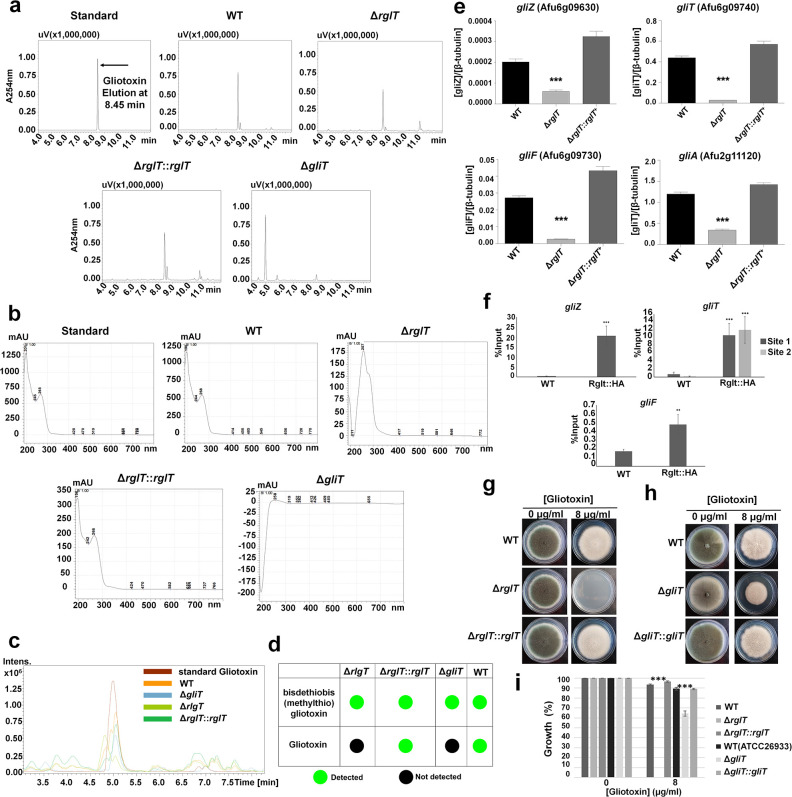
RglT is crucial for gliotoxin (GT) biosynthesis.a, HPLC (high performance liquid chromatography) analysis for GT of supernatants of different strains, that were grown for 72 h in GT-inducing conditions, showed similar chromatographs for all strains except for the ΔgliT strain (negative control). Standard GT (positive control) eluted after 8.45 min at 254 nm. All experiments were performed in biological triplicates. b, UV-vis spectra of the ΔrglT and ΔgliT strains differ from the spectra of the wild-type (WT) and ΔrglT::rglT+ strains, indicating the absence of GT. c, LC-MS (Liquid Chromatography-Mass Spectrometry) of biological triplicates, confirms the absence of GT from the supernatant of the ΔrglT strain. Shown are the extended chromatograms of organic extracts from: (1, brown) standard gliotoxin; (2, orange) WT; (3, dark green) ΔrglT::rglT; (4, pale green) ΔrglT; (5, blue) ΔgliT. d, The ΔrglT strain does not produce GT. Diagram summarizing in which strains GT or BmGT [bisdethiobis(methylthio)gliotoxin] was detected. e, RglT is essential for gliZ, gliT, gliF and gtmA expression in GT-inducing conditions. RT-qPCR was performed after strains were grown for 72 h in GT-inducing conditions. Gene expression was normalized by the β-tubulin-encoding gene. Standard deviations represent three biological replicates (**P-value < 0.001, ***P-value < 0.0001 in a one-way ANOVA test). f, RglT binds to the promoter regions of gliZ, gliT and gliF in GT-inducing conditions. ChIP (chromatin-immunoprecipitation)-qPCR was performed for the WT and RglT::HA strains when grown for 48 h in GT-inducing conditions. Binding motifs were identified by ChIP-sequencing and binding was calculated using the % input method, normalizing the RglT::HA-specific binding by the total cellular DNA (input). Standard deviations represent three biological replicates (**P-value < 0.001, ***P-value < 0.0001 in a paired, one-tailed student t-test). g-i, Endogenous GT resistance is completely abolished in the ΔrglT strain. Strains were grown for 5 days at 37°C on glucose minimal medium supplemented with or without GT (g, h). Graphs (i) show the percentage of growth in the presence of GT when compared to the control, no GT condition and standard deviations represent biological triplicates (***P-value < 0.0001 in a two-way ANOVA test).